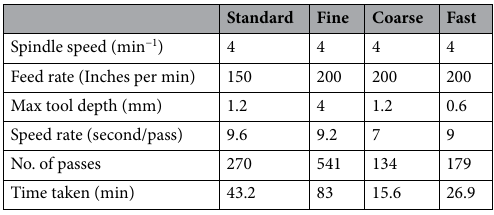
Table 1. Cutting conditions for each machined surface.